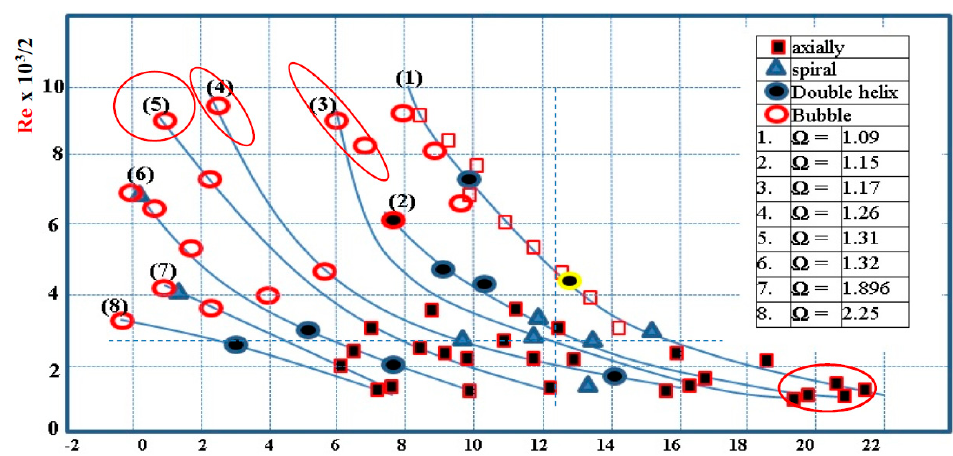
Figure 29. The neural network analysis for path fitting.